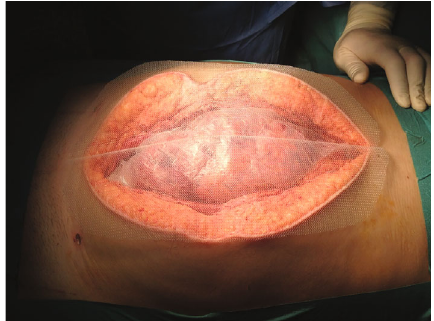
Figure 1: Confection of temporary abdominal closure due to abdominal compartment